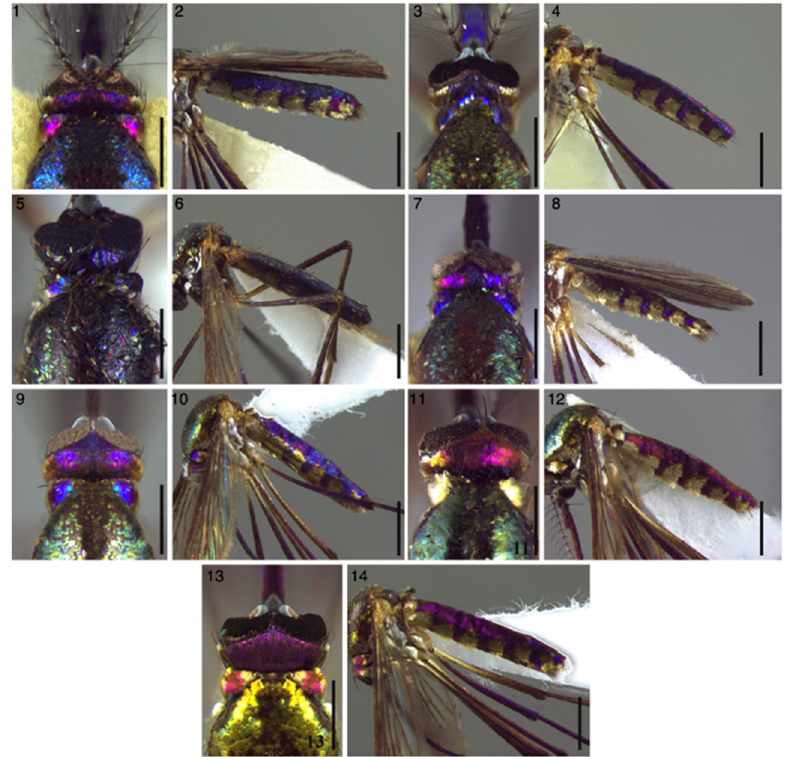
Figure 12. Examples of changes in color patterns characterizing the surface of different Sa. albiprivus specimens, which result from different types of reflection, i.e., purple, blue and green, or silver and gold, respectively. Bars = 1 mm (dorsal views, in images 1, 3, 4, 5, 7, 9, 11, 13), 0.5 mm (abdomen view, in images 2, 6, 8, 10, 12, 14). Color variations have been mostly ascribed to scale structural differences, assessed by scanning electron microscopy, and material composition, according to the results of principal component analysis performed by NIR analysis. Modified from [186].